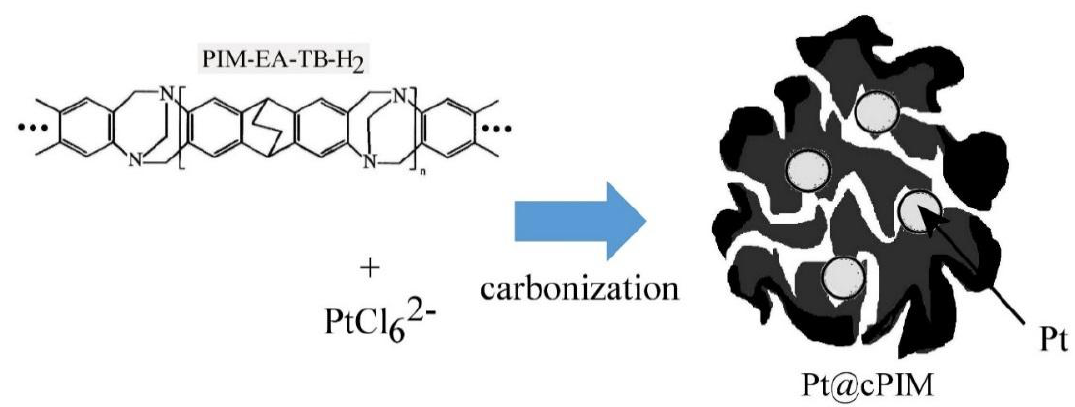
Figure 1. Molecular structure of PIM-EA-TB-H 2 and schematic depiction of the adsorption of hexachloroplatinic(IV) acid followed by mild vacuum carbonization to give a platinum nano-particle containing microporous heterocarbon.